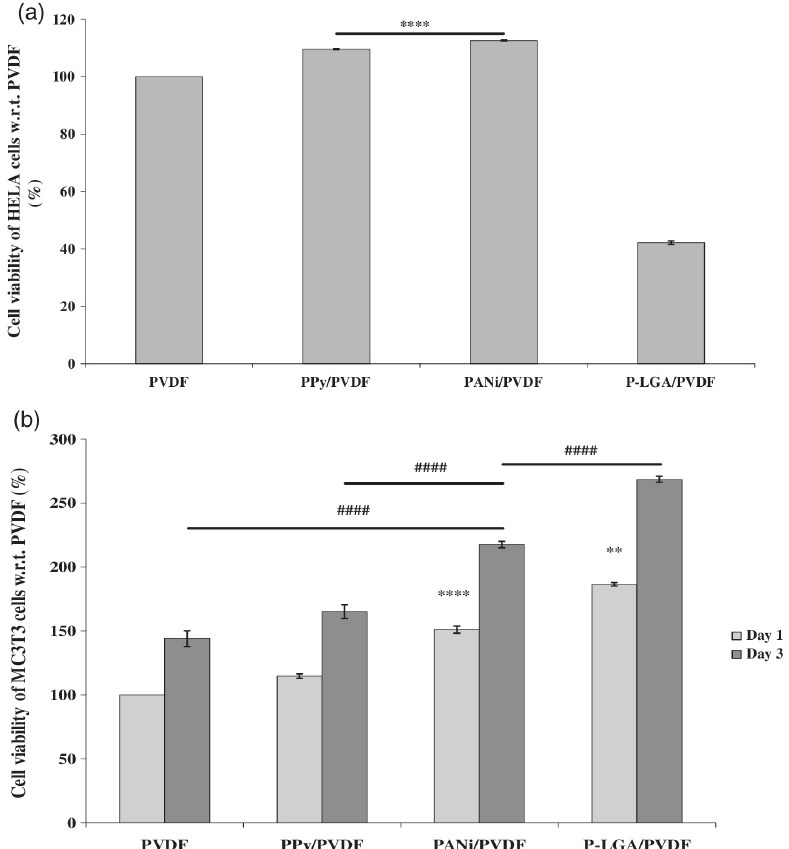
Figure 2: Viability of ( a ) HeLa cells and ( b ) MC3T3 cells on PVDF and PVDF:CP electrospun